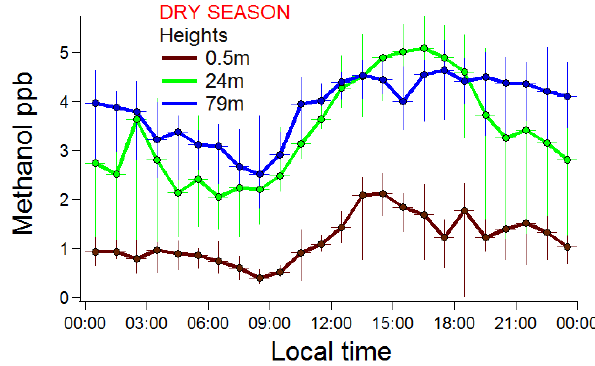
Figure 9. Diurnal hourly medians for methanol during the dry sea- son at different heights. Range bars are expressed as the 25 and 75%